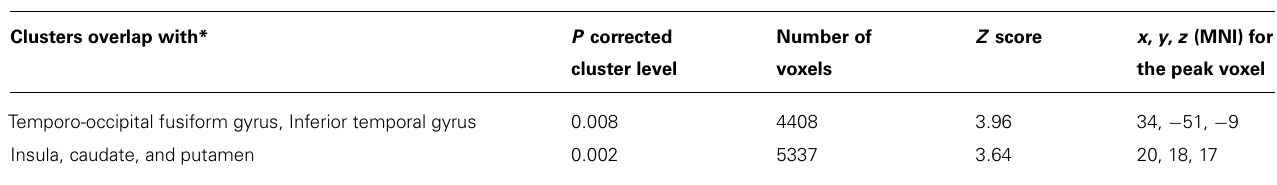
Number of Z score x , y , z (MNI) for cluster level voxels the peak voxel